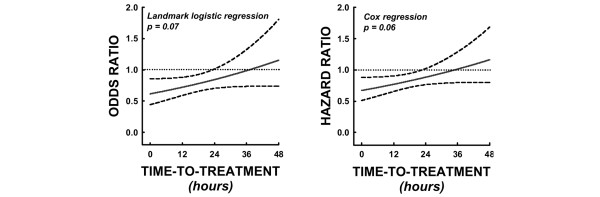
Landmark logistic and Cox regression analysis of DrotAA treatment effect by time to treatment. With the use of logistic (odds ratios for DrotAA versus placebo) and Cox (hazard ratios for DrotAA versus placebo) regression analyses, modeling of the treatment effect as a function of time to treatment was performed. In both analyses there was a trend (logistic regression, p = 0.06; Cox regression, p = 0.07) toward a more beneficial effect with earlier administration of DrotAA (solid line, ratios less than 1 until 36 hours). The most precise estimates of the model were between 12 and 24 hours, as indicated by the narrowest 95% confidence intervals (dashed lines). Outside this range, estimates of benefit were much less precise (that is, wider 95% confidence intervals furthest from the solid line). DrotAA, drotrecogin alfa (activated).